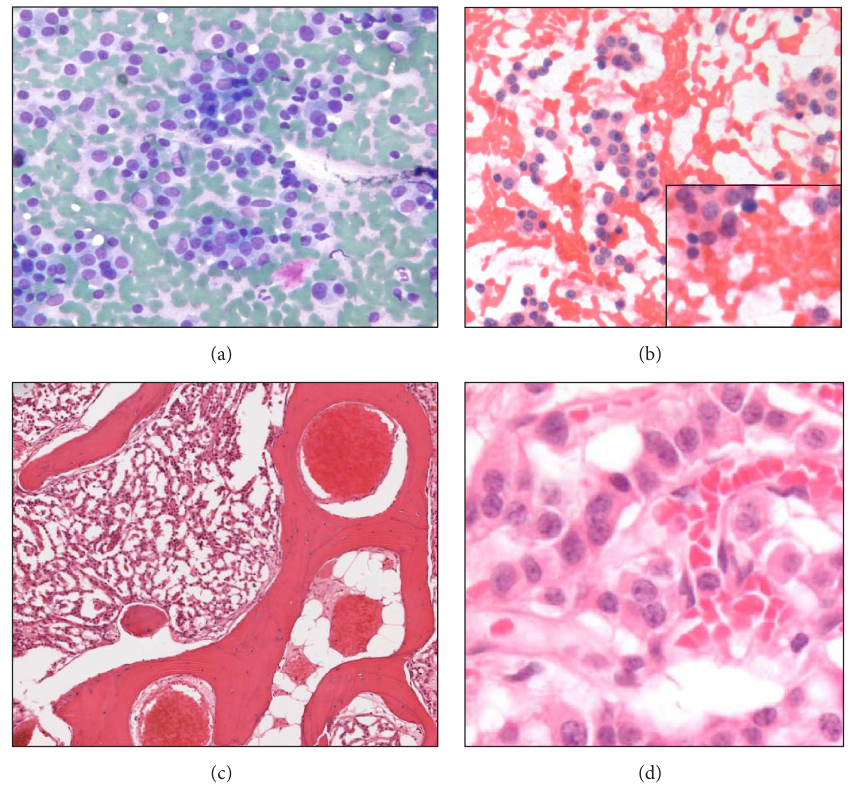
Figure 2: ((a) and (b)) Cytology scrape smears including Diff Quik, 20x (c) and H&E, 20x (inset 40x); (c) H&E section of calcified mass demonstrating mature lamellar bone and nests of tumor cells; (d) trabecular structures and vague rosettes were noted (40x); the tumor cells were diffusely positive for chromogranin positivity, synaptophysin, and cytokeratin